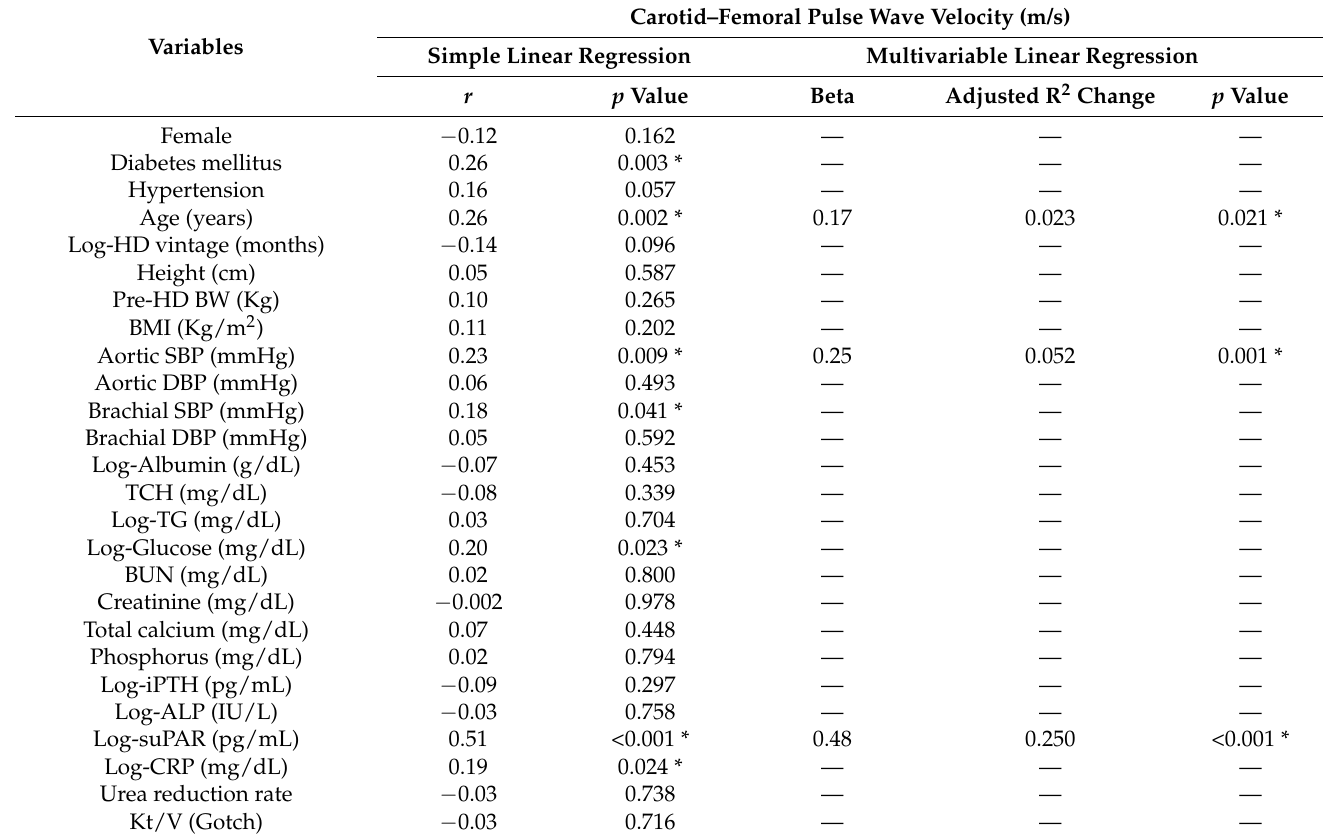
Table 3. Factors correlated to carotid–femoral pulse wave velocity, determined by linear regression analysis.